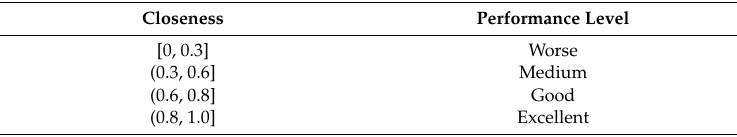
Table 2. Performance level criteria.